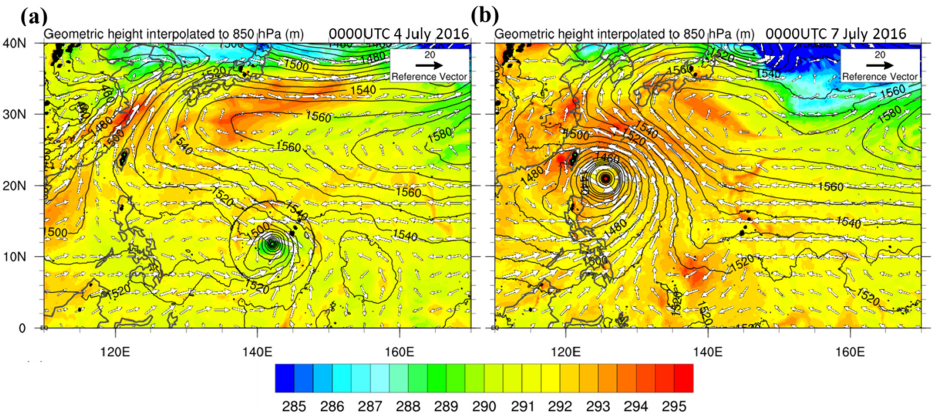
Figure 10. Geometric height (contours at an interval of 10 m), temperature (shaded in K), and wind (vectors in m s − 1 ) at 850 hPa at ( a ) 0000 UTC 4 July 2016 and ( b ) 0000 UTC 7 July 2016 for BND_RP.